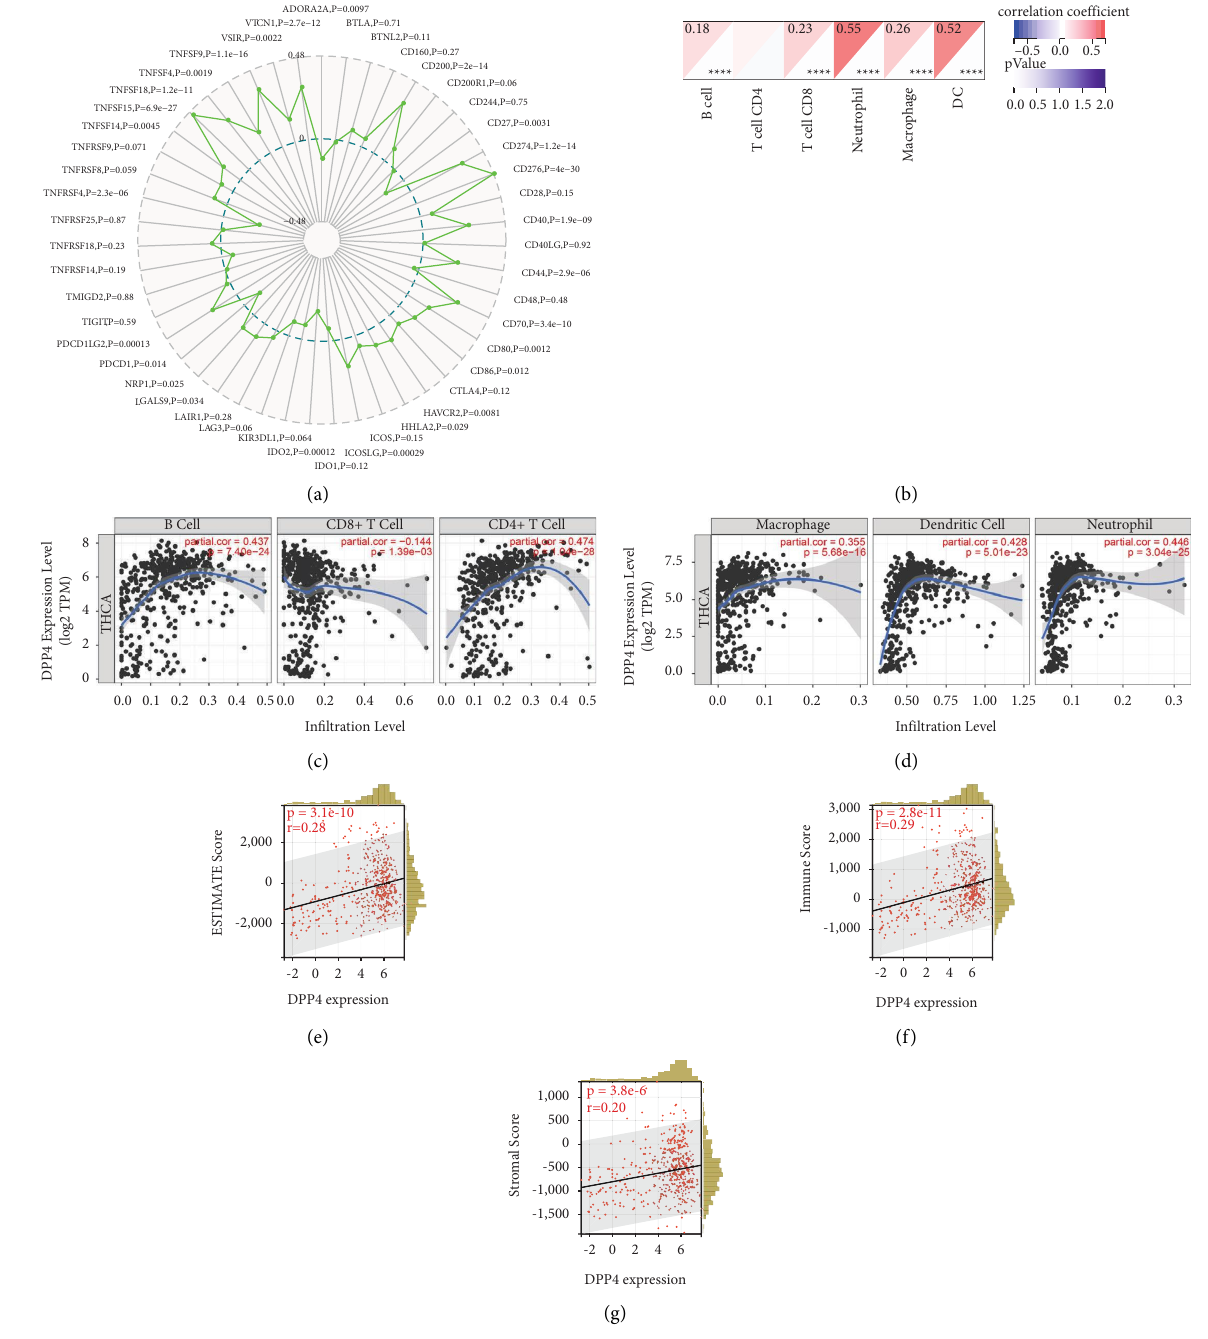
Figure 2: Te relationship between DPP4 and THCA tumor immunity. (a) Te correlation between the expression of 47 ICGs and DPP4 in THCA is analyzed. Among them, 21 ICGs were positively correlated with DPP4 and 5 were negatively correlated. (b) Te results from Sangerbox show that the expression of DPP4 is positively correlated with B cells, CD8+Tcells, neutrophils, macrophages, and DCs in THCA ( ∗∗∗∗ p < 0 . 001). (c, d) Te results from TIMER verify that the expression of DPP4 is positively correlated with B cells, CD4+T cells, neutrophils, macrophages, and DCs in THCA ( p < 0 . 001). Te scatterplots show partial Spearman’s rho value. (e) DPP4 expression is signifcantly correlated with the ESTIMATE score in THCA ( p < 0 . 001). (f) DPP4 expression is signifcantly correlated with the immune score in THCA ( p < 0 . 001). (g) DPP4 expression is signifcantly correlated with the stromal score in THCA ( p < 0 .